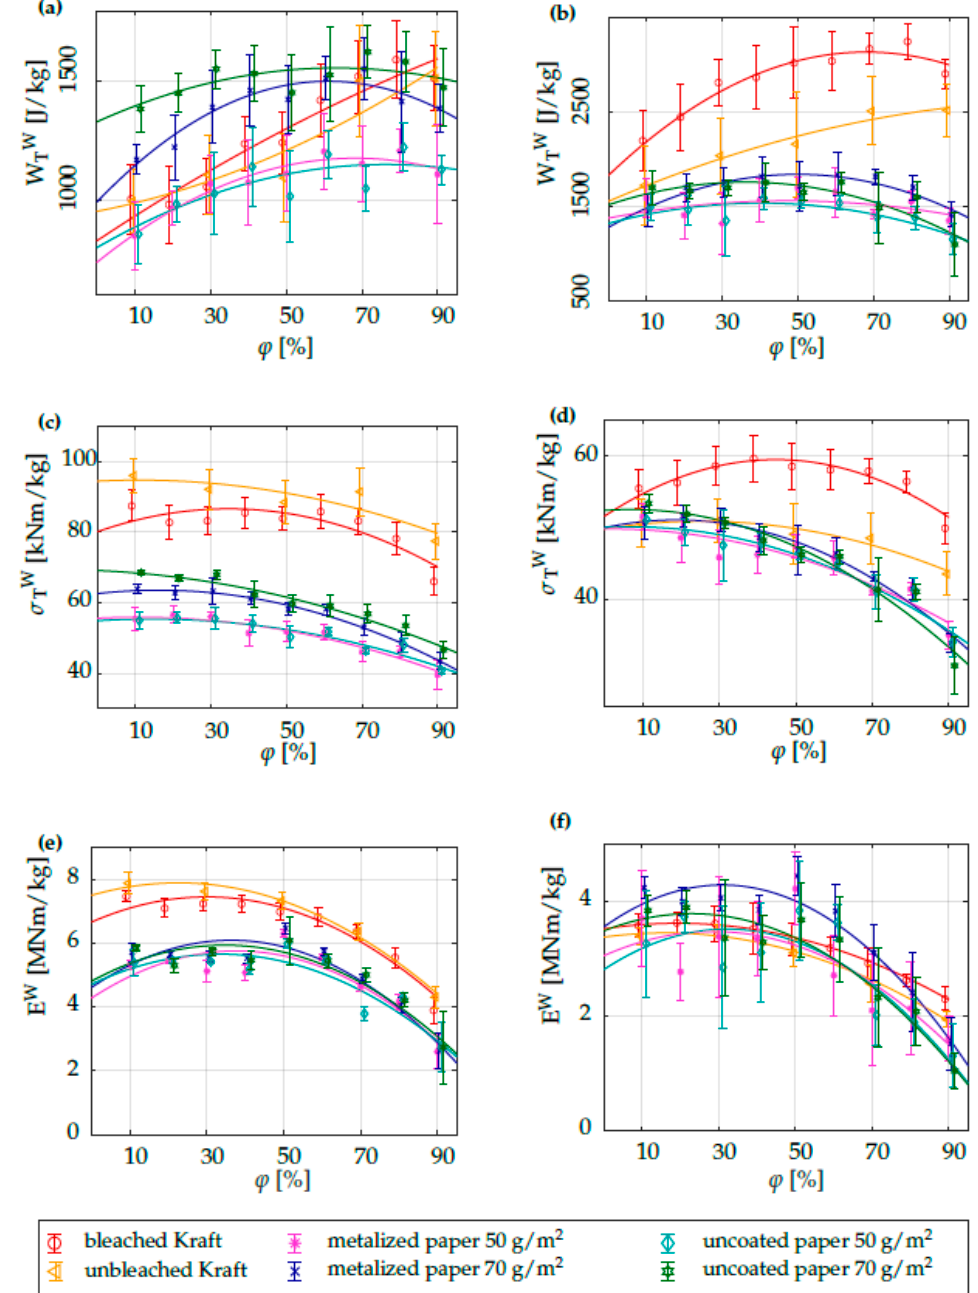
Figure 6. Tensile energy absorption index ( a , b ), breaking force index ( c , d ) and tensile stiffness index at different relative humidity in the machine direction ( a , c , e ) and the cross direction ( b , d , f ).